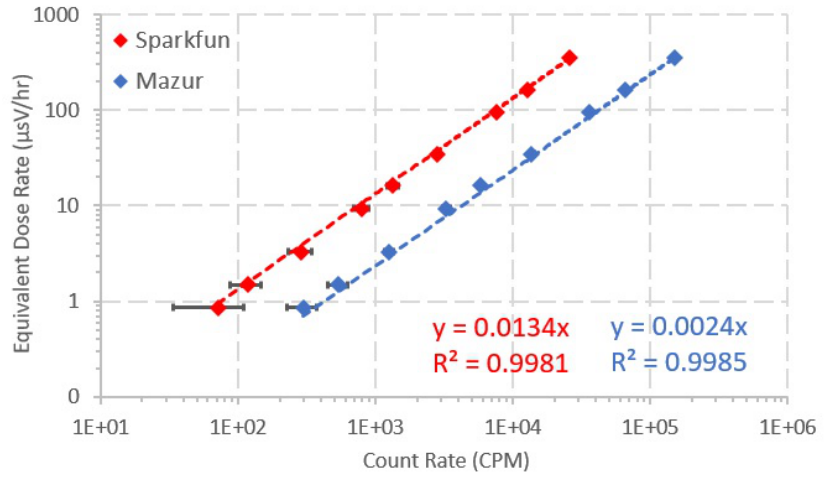
Figure 9. Equivalent dose rate as a function of the count rate of the two GMCs. Nine data points were retrieved for each GMC, representing each data acquisition, one for each source-distance configuration. The least-squares linear fit of the data was calculated and is also